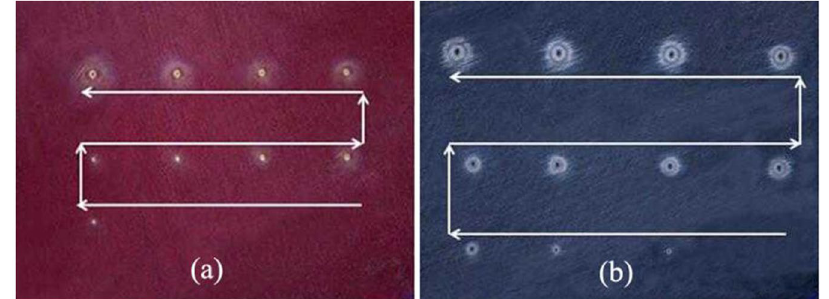
Figure 2. Laser-induced damage arrays after irradiation with a 3 μ m femtosecond laser on the 2 mm thickness samples: ( a ) As 2 S 3 glass; ( b ) As 2 Se 3 glass. (Laser average power increasing as arrows shows).